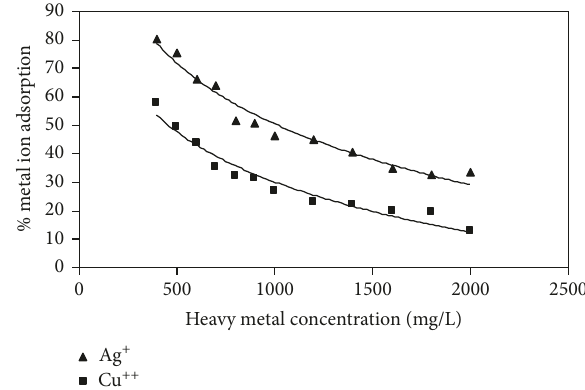
Figure 6: Adsorption of Ag + and Cu ++ by the Saudi clay sample as a function of initial